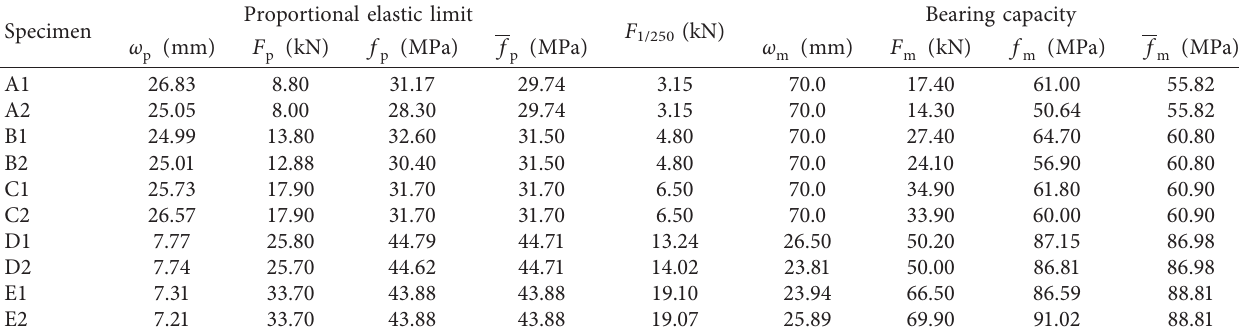
Table 3: Main test results of specimens. Proportional elastic